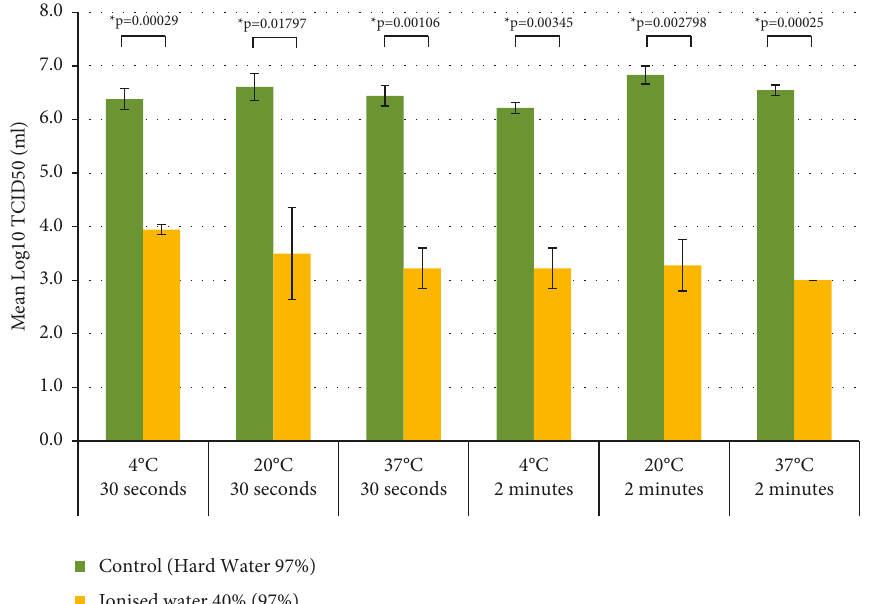
Figure 1: Comparison of the mean TCID50/ml obtained for SARS-CoV-2 infected cells in the control (hard water 97%) and ionised water 40% (97%) after 30 seconds and 2min exposure at 4 ° C, 20 ° C, and 37 °